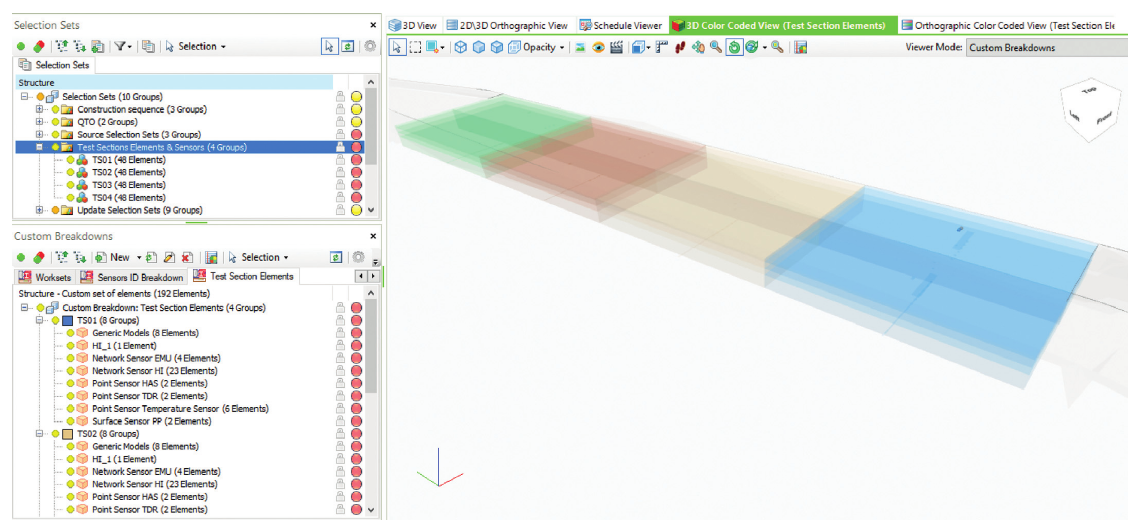
Figure 9: Colour coded element breakdown.